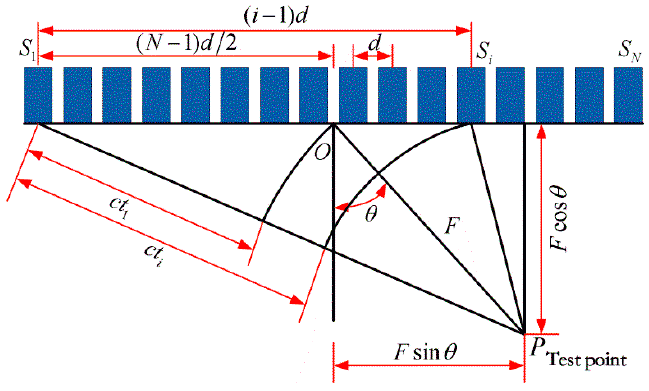
Figure 1. Geometry of the linear phased array used to derive the focusing formula.